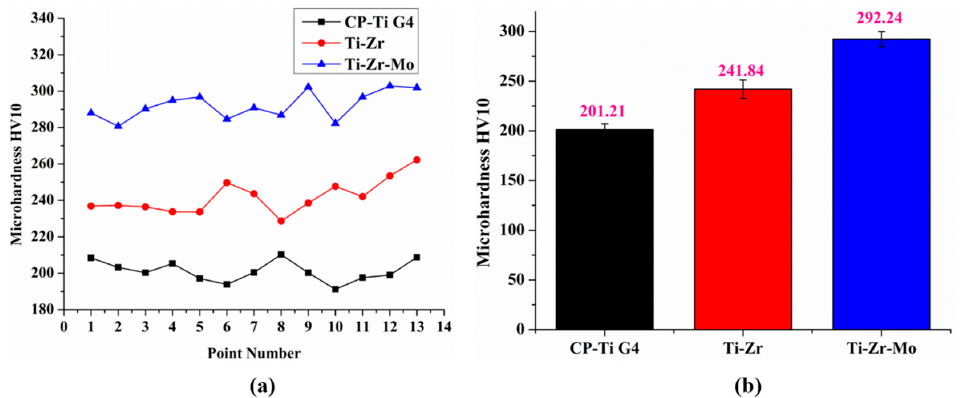
Figure 4. ( a ) Vickers microhardness by point numbers. ( b ) bar plots of average values of Vickers microhardness.